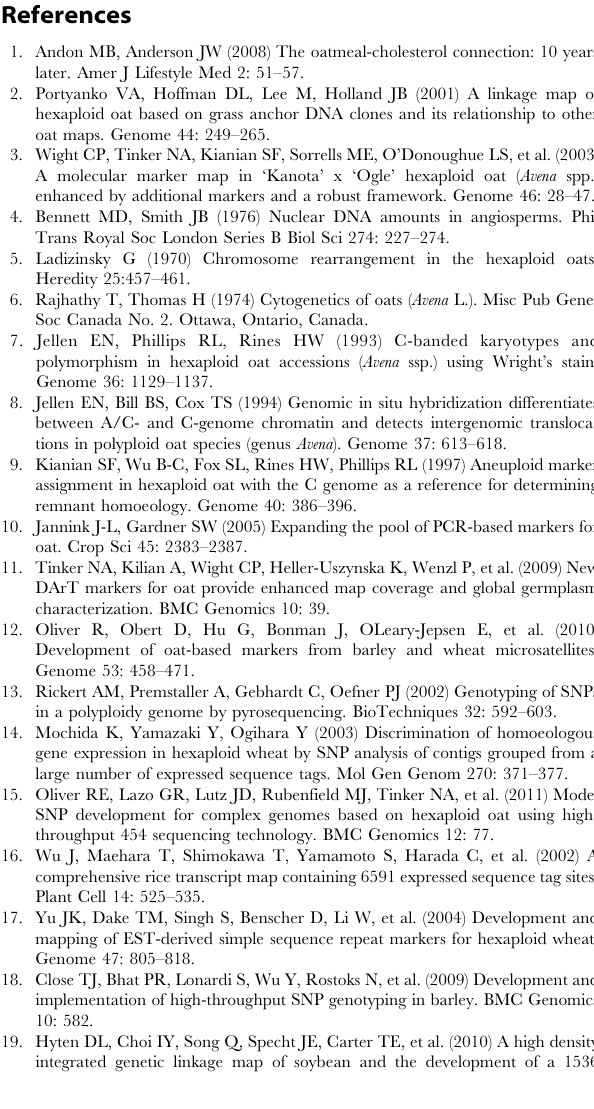
Dataset S4 Sequences for in silico SNP assays analyzed with the GoldenGate genotyping